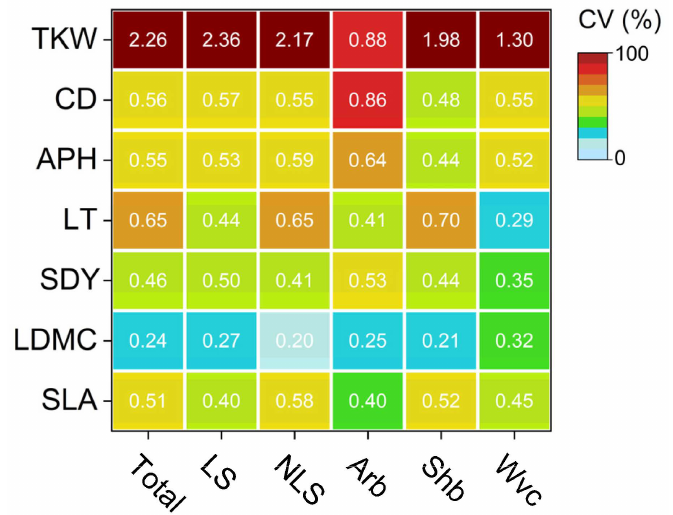
Figure 3. Coefficient of variation of woody plant functional traits in different classes. Abbreviations are as follows: TKW, thousand kernel weight; CD, crown diameter; APH, average plant height; LT, leaf thickness; SDY, stem density; LDMC, leaf dry matter content; SLA, specific leaf area; LS: landslide; NLS: not landslide; Arb: arbor; Shb: shrubs and small size arbor; Wvc: Woody vines and climbing shrubs.